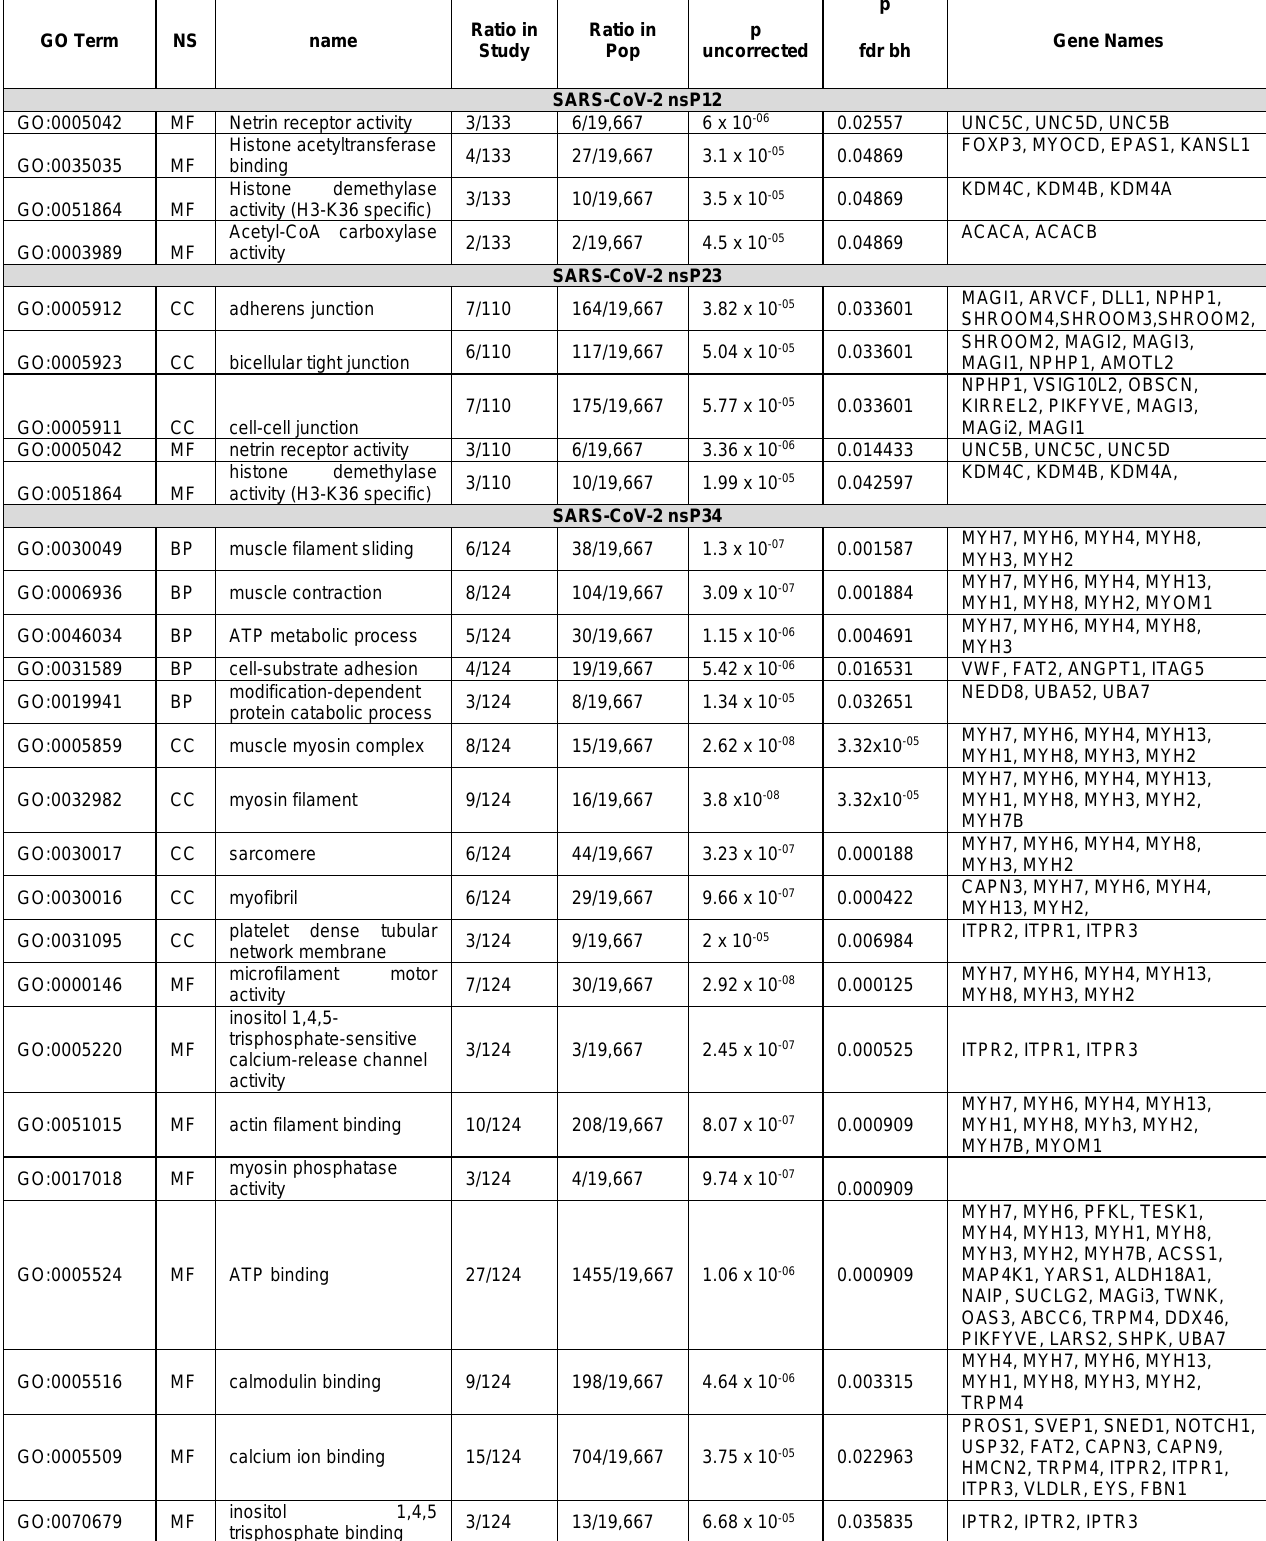
GOATOOL results from the SARS-CoV-2 PLpro nsP1/2 (SGVTRELMRELNGG*AYTRYV), nsP2/3 (NMMVTNNTFTLKGG*APTKVT) and nsP3/4 (VVNVVTTKIALKGG*KIVNNW) junctional cleavage sites from PHI- BLAST searches.